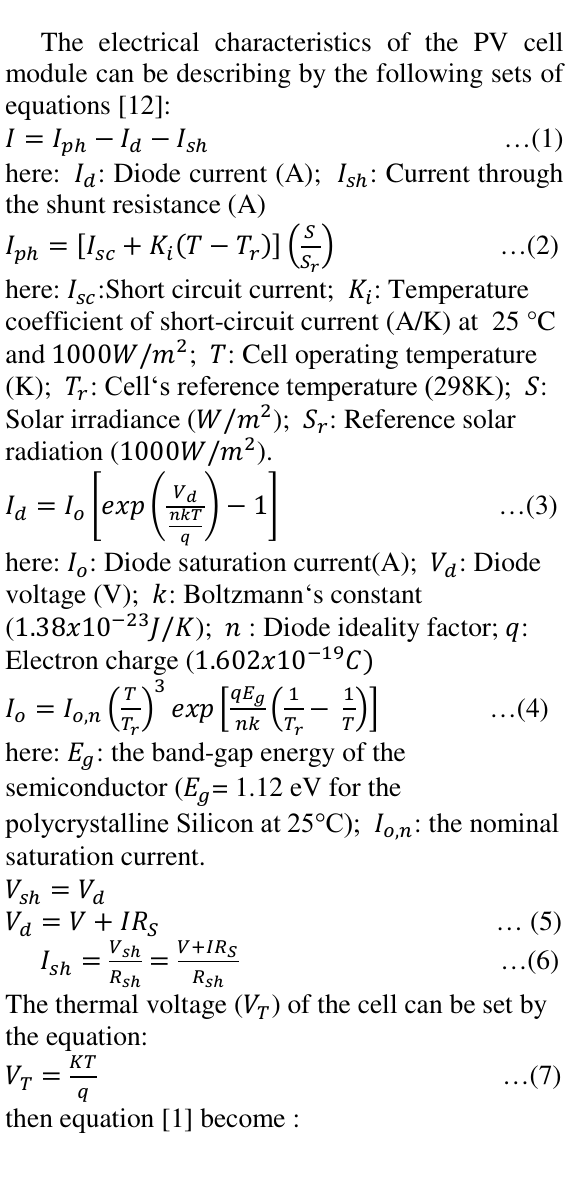
Fig. 1. Solar cell model. The electrical characteristics of the PV